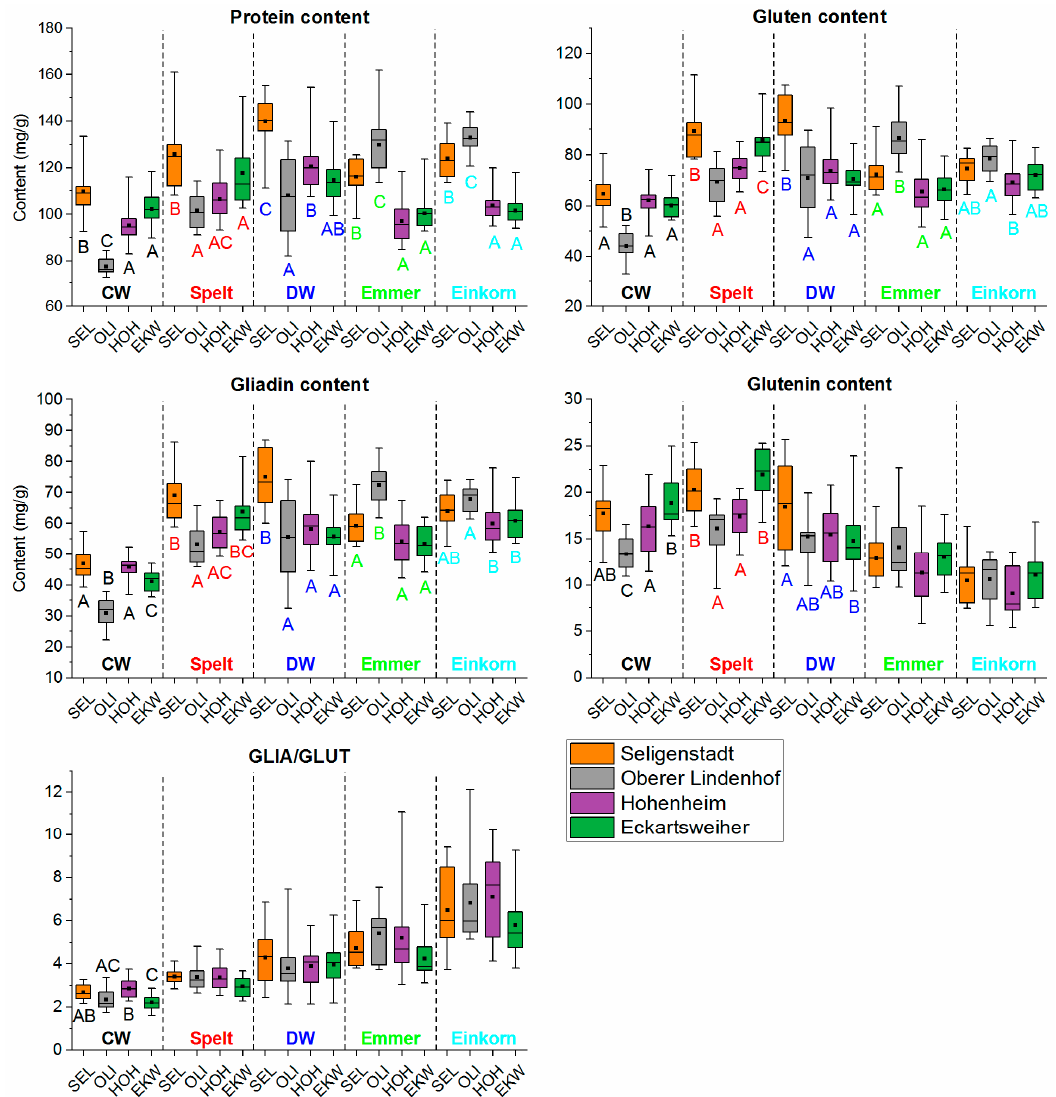
Figure 3. Contents of protein, gluten, gliadins, glutenins and the ratio between gliadins and glutenins (GLIA / GLUT) in common wheat (CW), spelt, durum wheat (DW), emmer and einkorn. Data are presented as median (line in the box) of 15 cultivars per wheat species and growing location (SEL, Seligenstadt; OLI, Oberer Lindenhof; HOH, Hohenheim; EKW, Eckartsweiher), boxes represent the interquartile range, the rectangle in the box represents the mean value, whiskers designate minima and maxima and different capital letters indicate significant differences between growing locations within each wheat species (one-way ANOVA, Tukey’s test at p < 0.05).